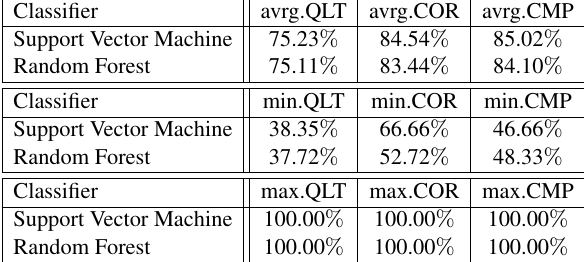
Figure 4. Results of the classified EnMAP contest dataset with two state-of-the-are classifiers. Left: Support Vector Machine (SVM); Centre: view for visual evaluation; Right: Random Forest (RF). Larger image available at: www.ipf.kit.edu/code.php Table 1. Confusion matrix values for Support Vector Machine and Random Forest. Average, minimum and maximum values of class-specific measures represented by quality (QLT), correctness (COR) and completeness